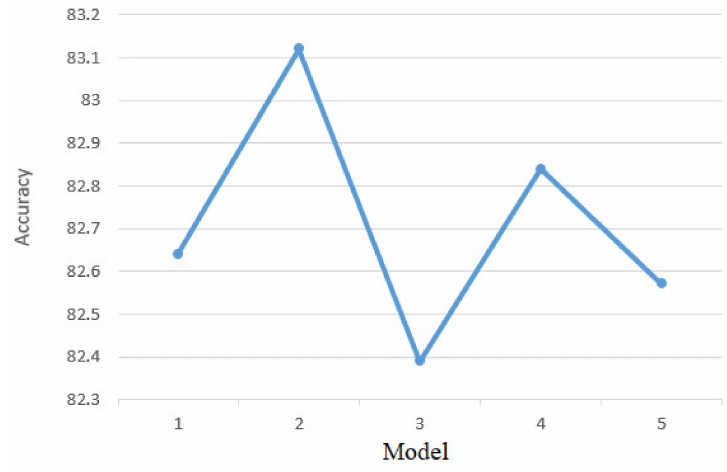
Figure 13. Five-fold cross-validation results.